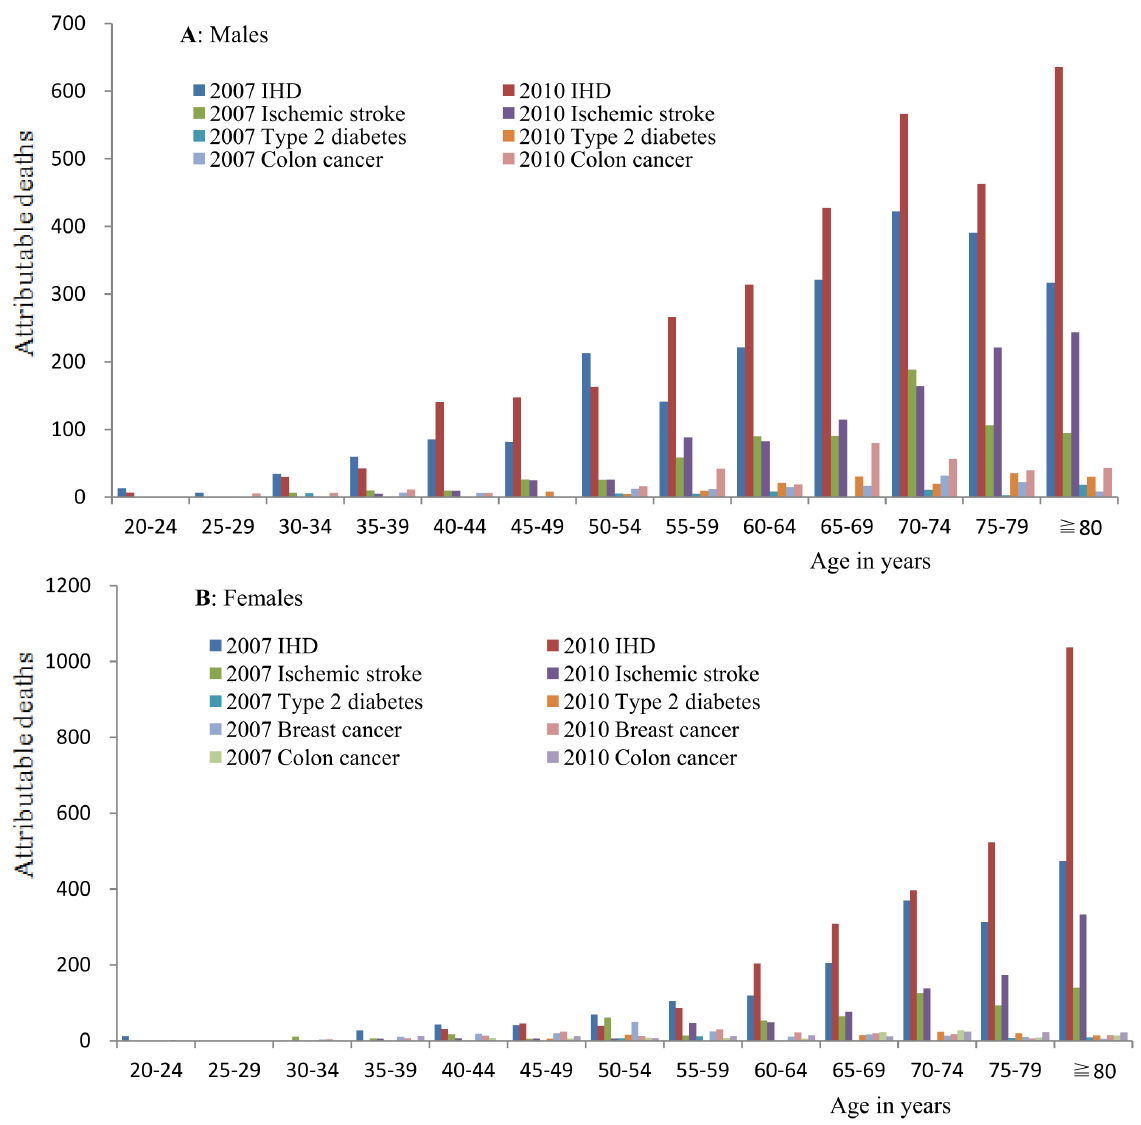
Figure 1. Deaths attributable to insufficient physical activity by age and sex, Jiangxi province of China in 2007 and 2010.